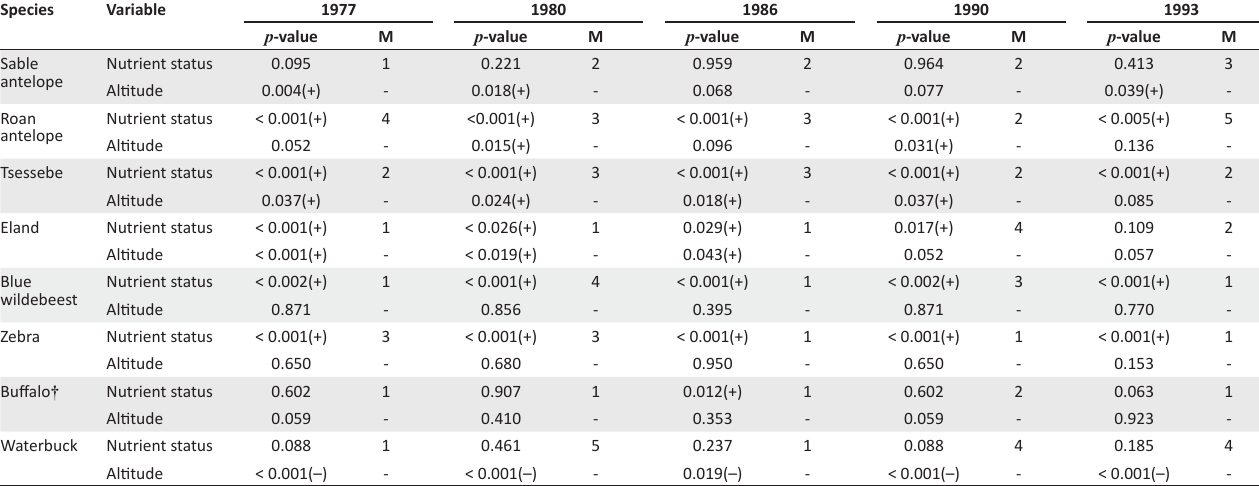
TABLE 1: Multiple regression analyses of population densities on habitat variables of nutrient status and altitude (northern Kruger National Park). Species